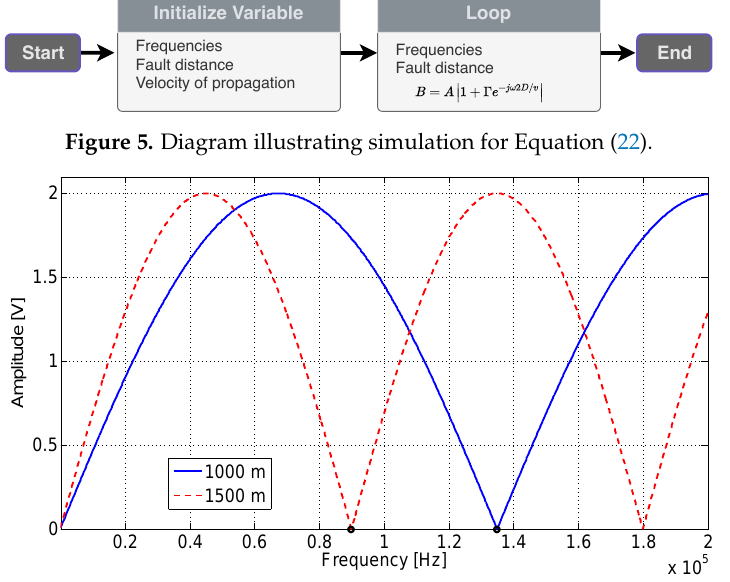
Figure 6. Behavior of the observed amplitude B with respect to the frequency as in (22). Short at 1000 m and 1500 m. The velocity of propagation v is considered as 90% the velocity of light and the frequency bandwidth is 100 Hz up to 200 kHz. The frequency was varied in steps of 100 Hz. The dots marked with a circle correspond to the identification of the null.